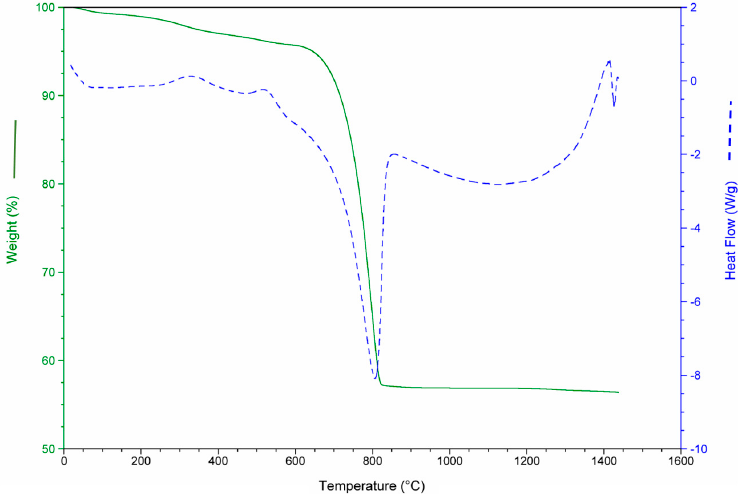
Figure 3. Mass loss and heat flow of construction and demolition waste (CDW).